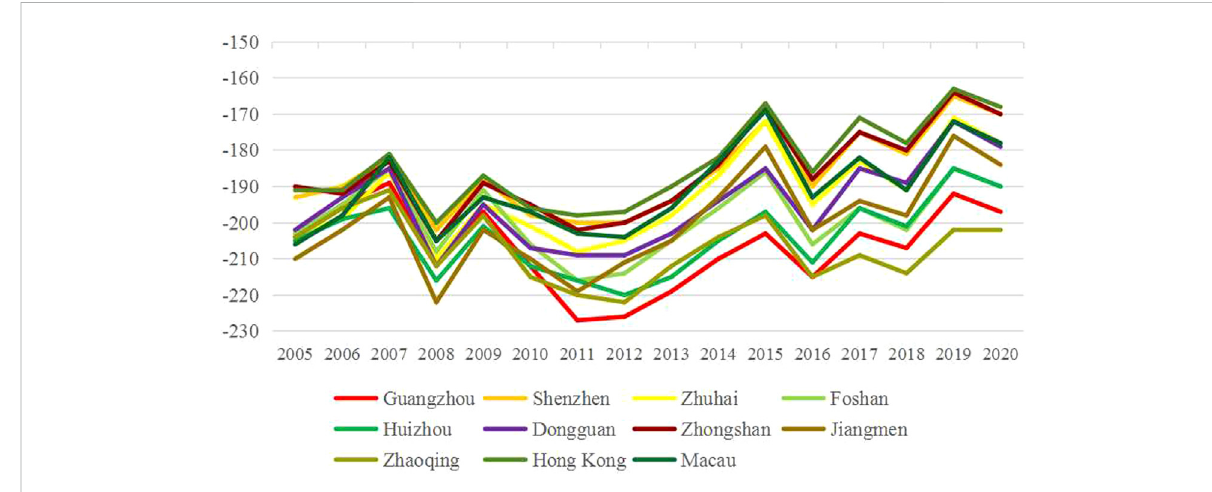
FIGURE 4 Temporal evolution diagram of the wind ef fi ciency index from 2005 to 2020.